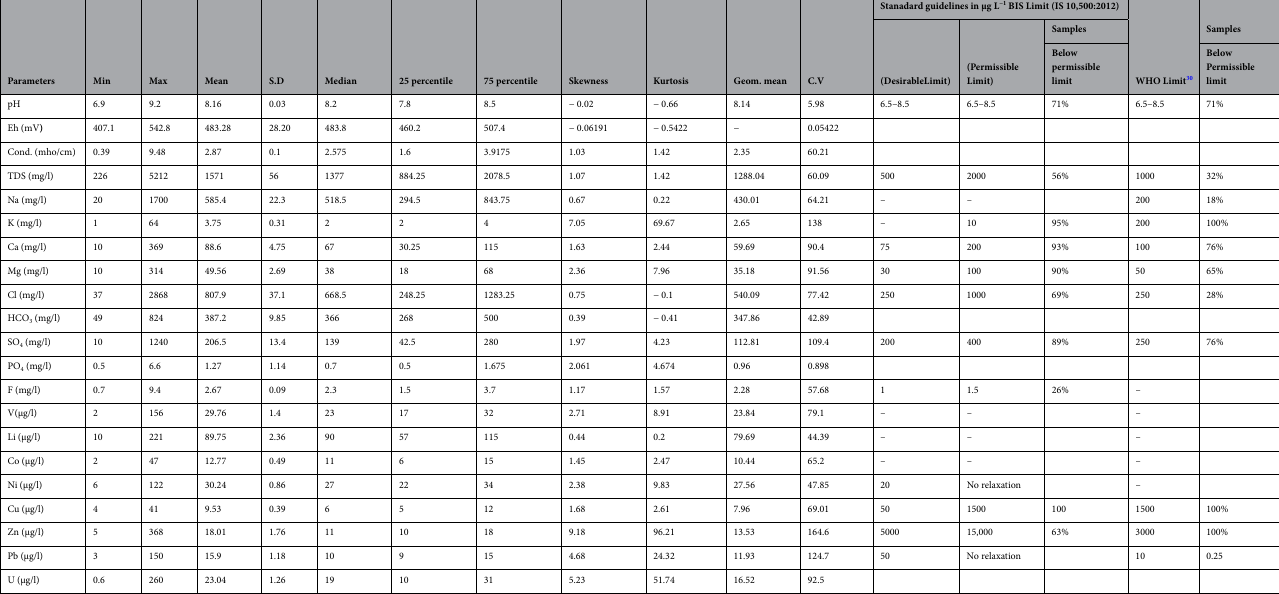
The piper plot in Fig. S3 highlights the hydrochemical facies of U < 30 ppb, 30 ppb < U < 60 ppb and U > 60 ppb in the group TDS1, TDS2, and TDS3. The correlation analy-